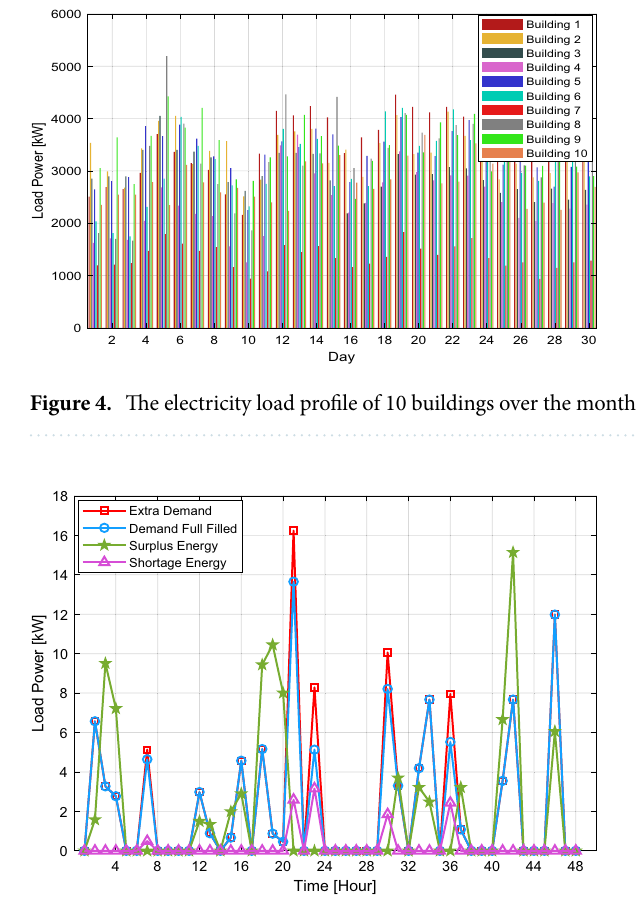
Figure 5. The building’s extra energy requirement, as well as the excess energy with and without